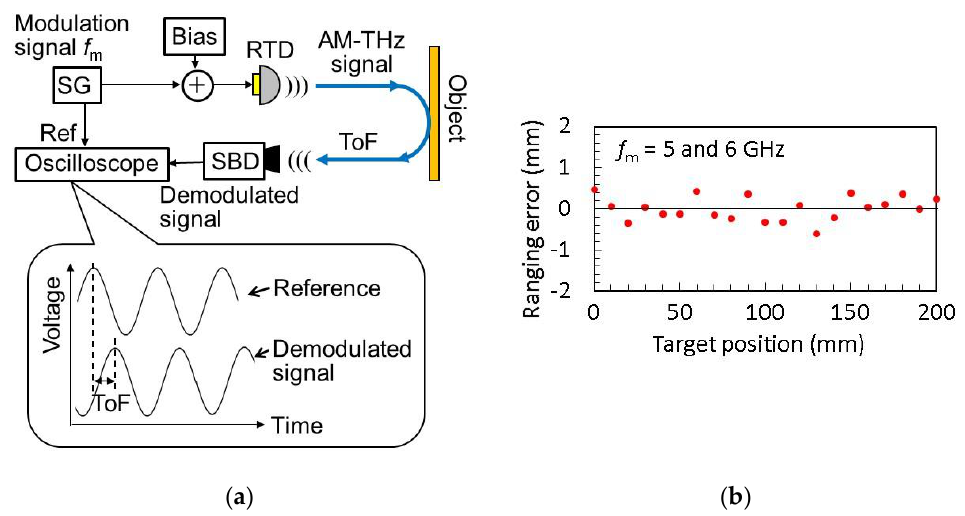
Figure 13. THz radar system using RTD oscillator [43, 44]: ( a ) Simplified schematic diagram of THz radar system using RTD oscillator with the amplitude-modulated continuous wave (AMCW)—SG: signal generator, and ( b ) error evaluated for the distance measurement with the AMCW using two modulation frequencies.